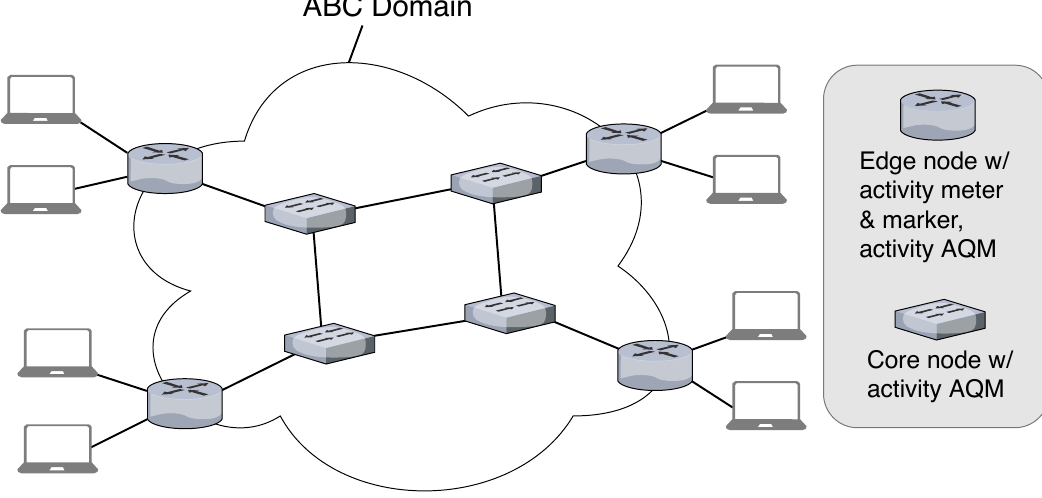
Figure 1. Activity metering and marking is performed only by ingress nodes. Both ingress and core nodes apply activity active queue management (AQM) during packet